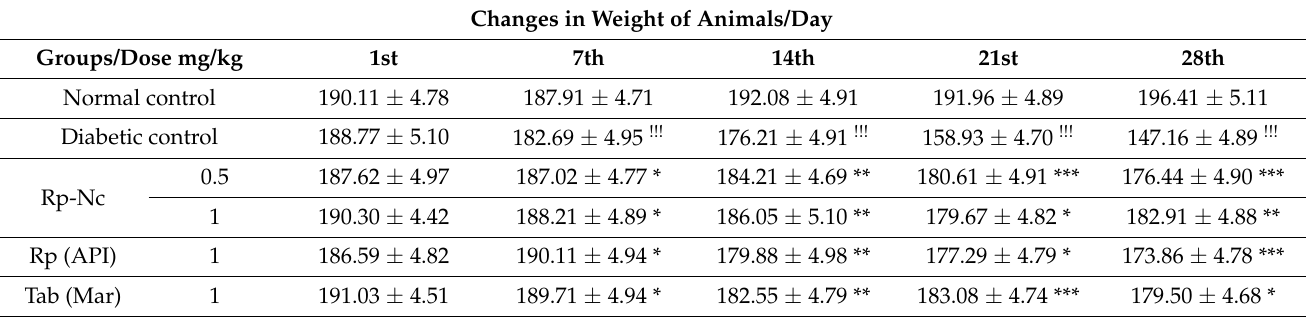
Table 4. Effect of Rp-Nc on body weight of animals.